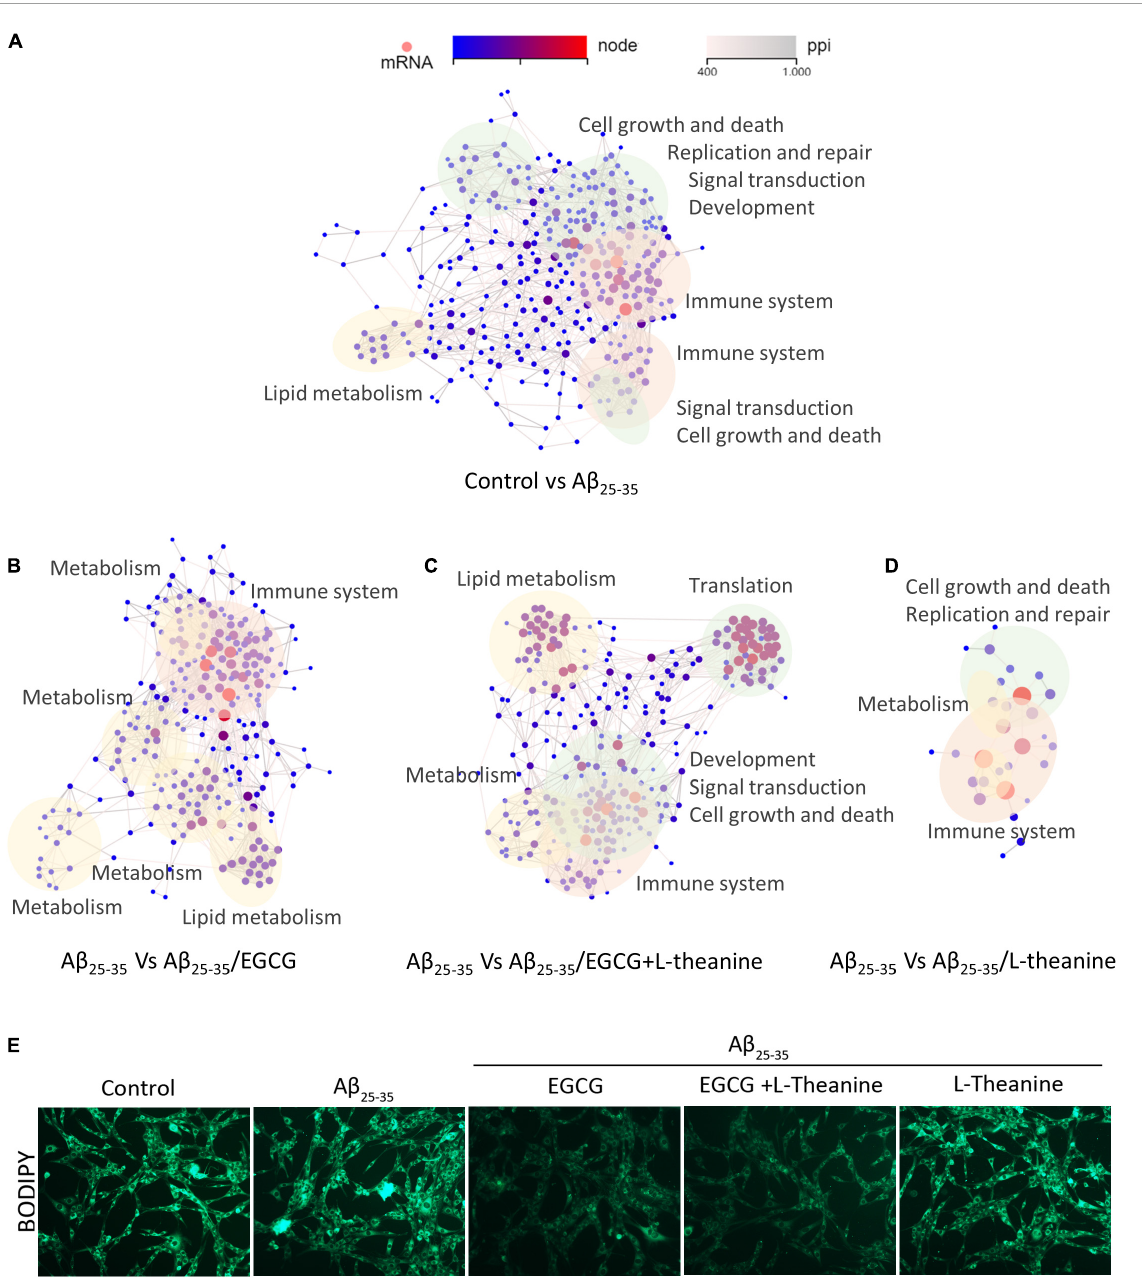
FIGURE8 Network interaction plot (PPI) analysis of differential genes in different treatment groups. (A–D) Interaction analysis of differential genes in different treatment groups. The yellow blocks in the panel represent metabolisms such as lipids, carbohydrates, amino acids, and energy; green blocks represent signal transduction such as cell growth and death, cellular community and endocrine system, genetic information procession, replication, and repair, etc.; pink blocks represent signal transduction, such as inflammation and immune system. The gray lines represent functional associations of differential genes; the nodes from blue to red represent the ranges of enriched differential genes, from panels (A–D) are 1 ∼ 64, 1 ∼ 58, 1 ∼ 45, and 1 ∼ 9, respectively. (E) BODIPY staining of cell lipid droplets in different treatment groups.